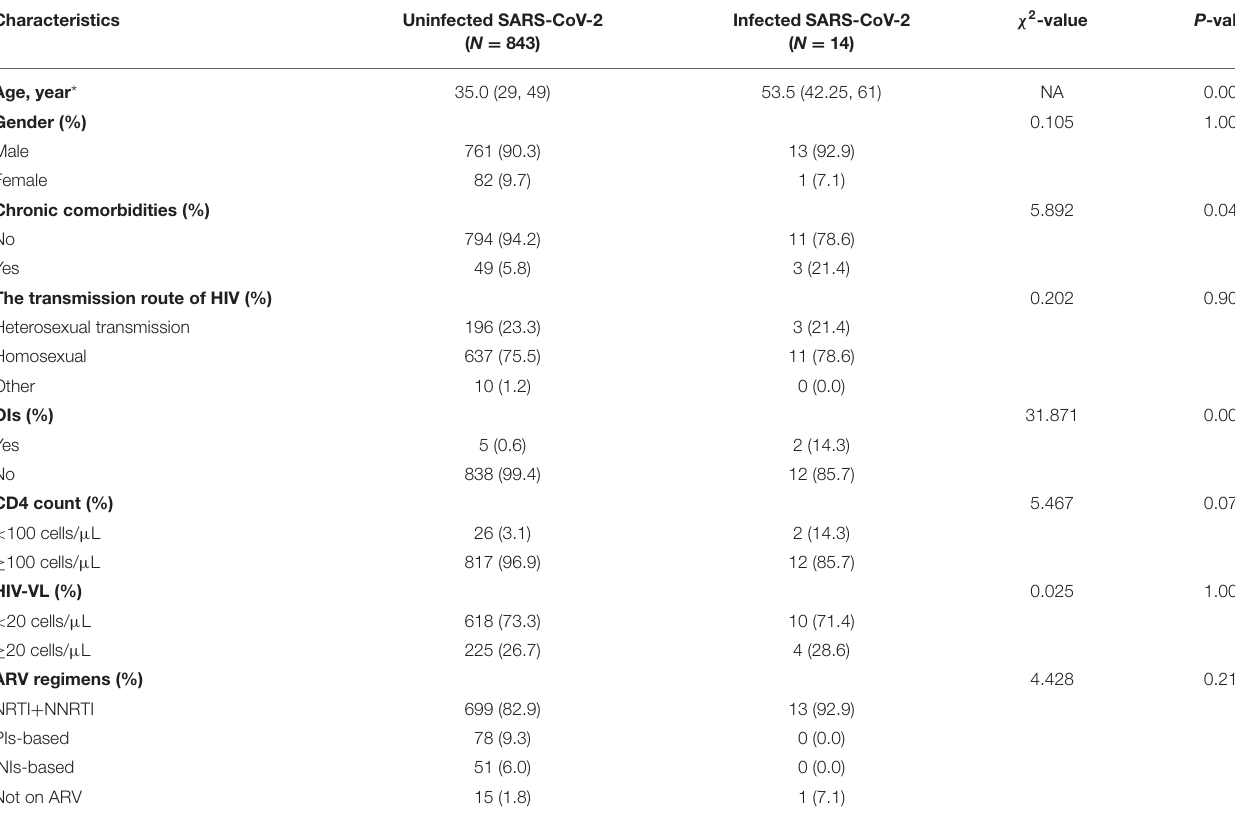
TABLE 3 | Demographic features of enrolled PLWH in Wuhan, China, 2020 ( N = 857).